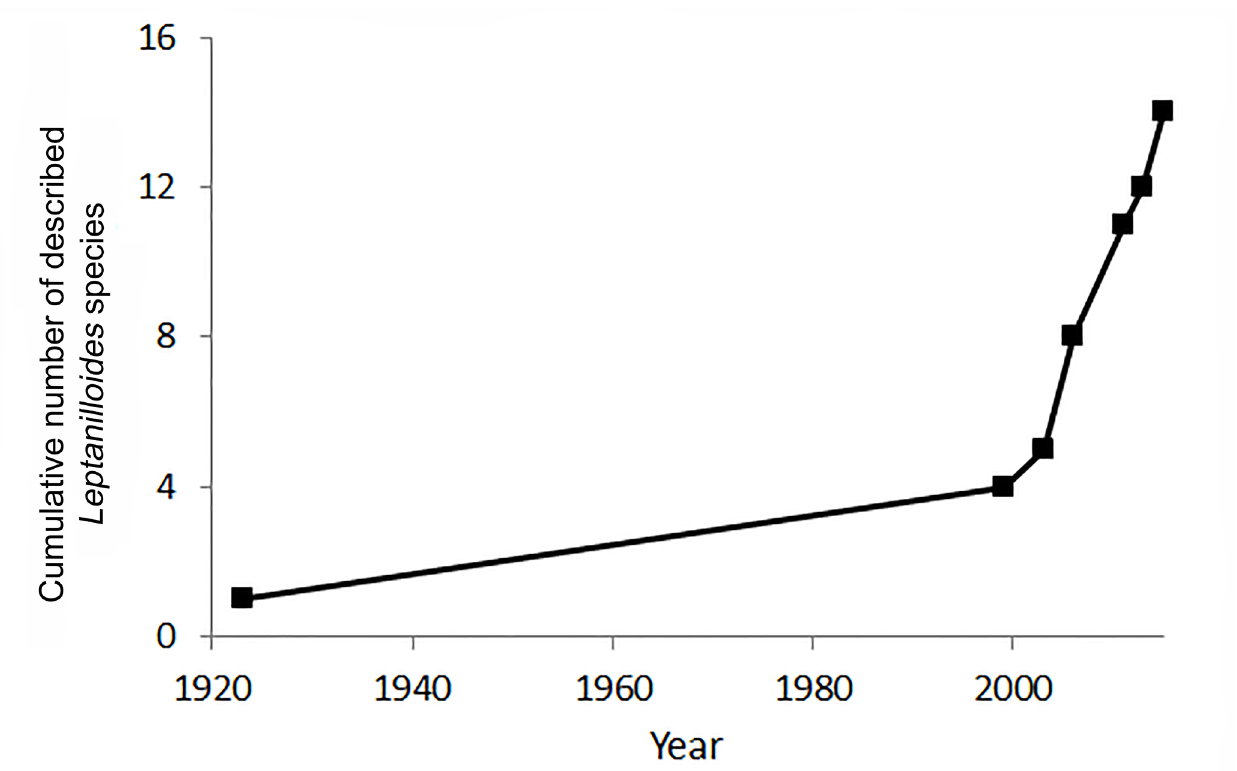
Fig. 13. Cumulative number of described species of Leptanilloides Mann, 1823 over time, since the description of L. biconstricta Mann,